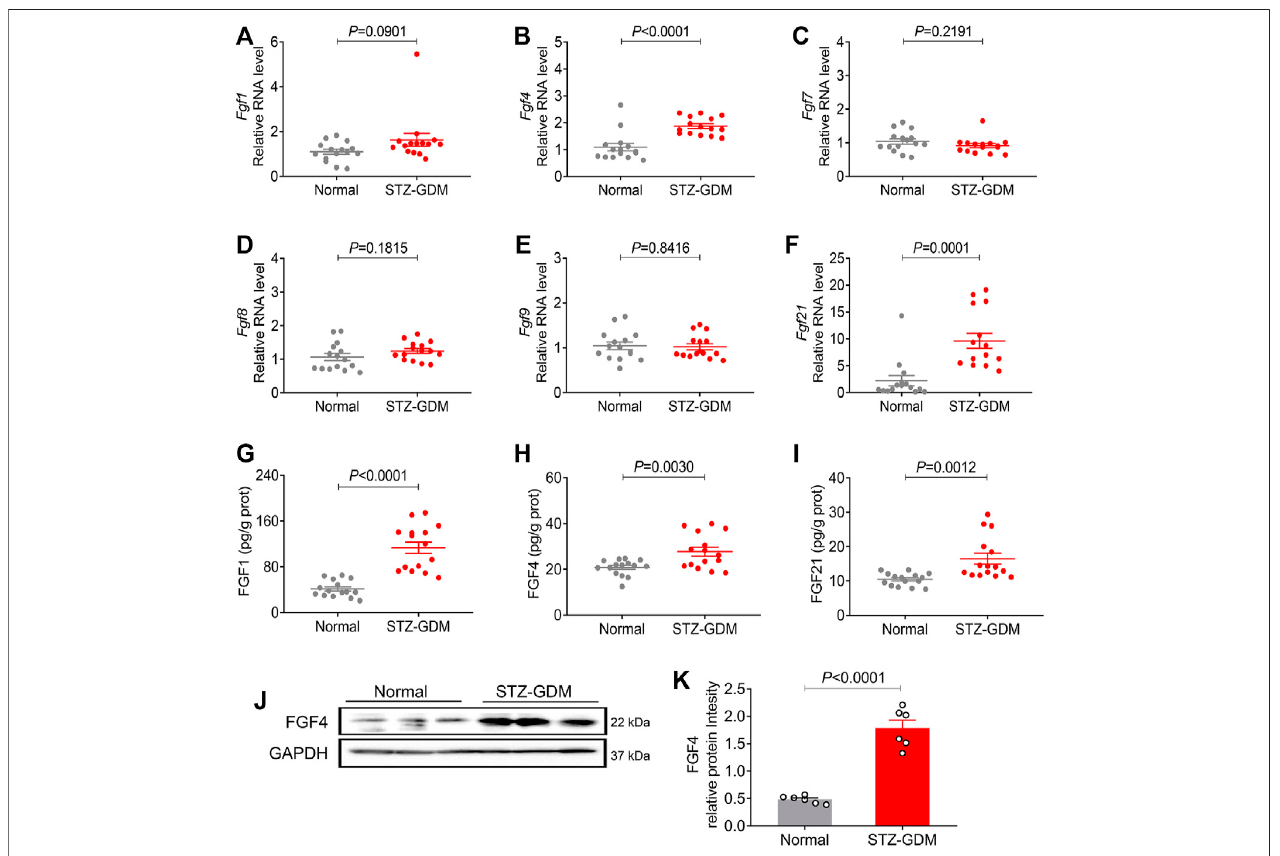
FIGURE 3| The mRNA and protein expression of representativeFGF family membersin placentas ofSTZ induced GDM animal models. ( A – F ) The mRNA levels of Fgf1 , Fgf4 , Fgf7 , Fgf8 , Fgf9 , and Fgf21 were analyzed using RT-PCR. (G – I) The protein expression levels of the placental FGF1, FGF4 and FGF21 were detected using ELISA kit. These experiments were performed using fi fteen placentas from different mice per group. Data are presented as mean values ±SEM ( n = 15). (J) The FGF4 protein expression levels were detected using western blotting (three placentas from different mice per group), and representative images from two independent experiments were shown. (K) Densitometric quanti fi cation of western blots shown in (J) . Data are presented as mean values ±SEM ( n = 6); a value of p < 0.05 was considered to be statistically signi fi cant.